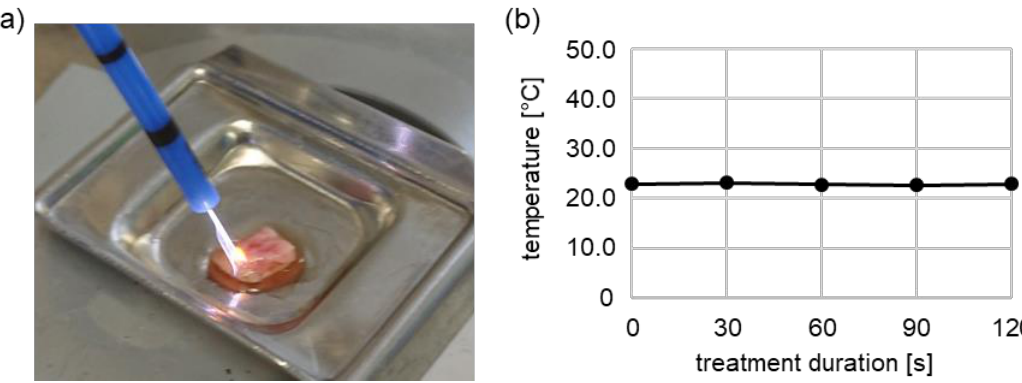
Figure 4. Superficial NIPP treatment of human cervix uteri. ( a ) Superficial treatment of cervical tissue with the Vio3/APC3. Laser thermographic assessment of tissue temperatures during dynamic superficial treatment of human tissue samples ( b ). The results are expressed as the mean ± SD.